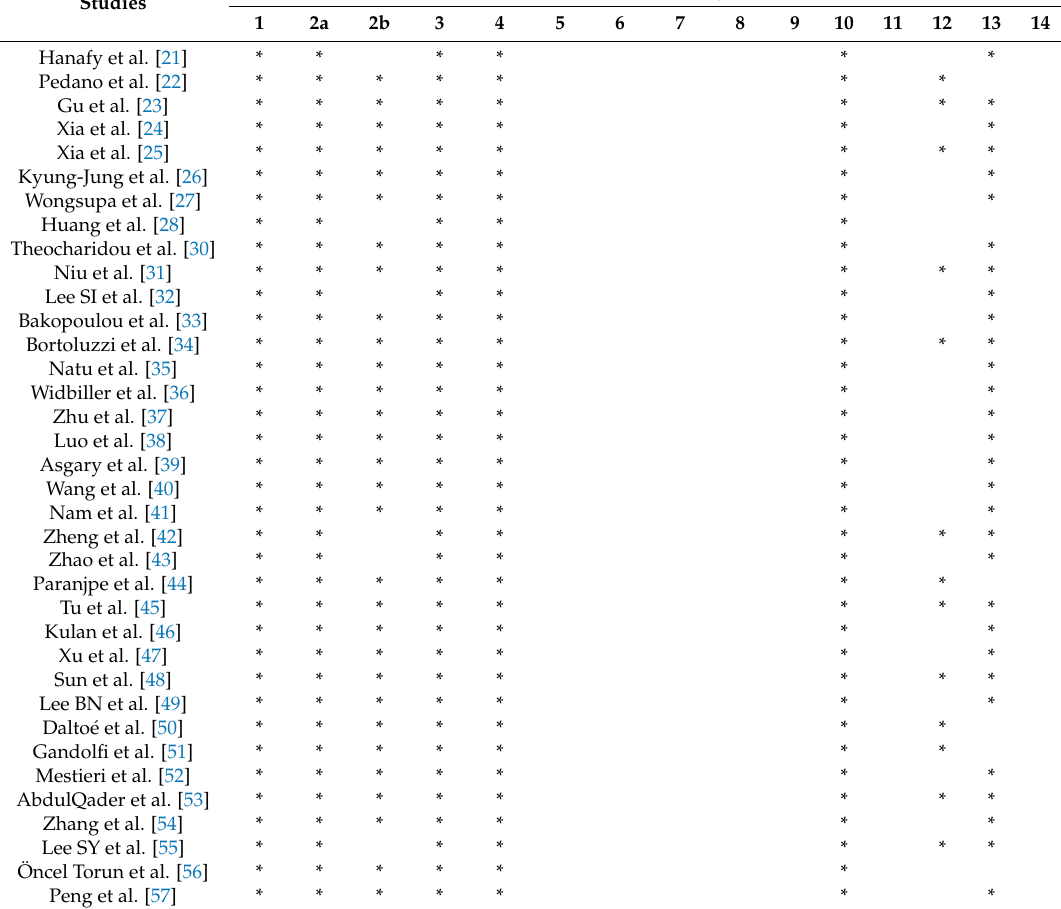
Table 5. Results of the assessment of in vitro studies by the use of the modified CONSORT checklist [19]. Cells marked with an asterisk “*” represent study fulfilment for the given quality assessment parameter. Cells left blank represent